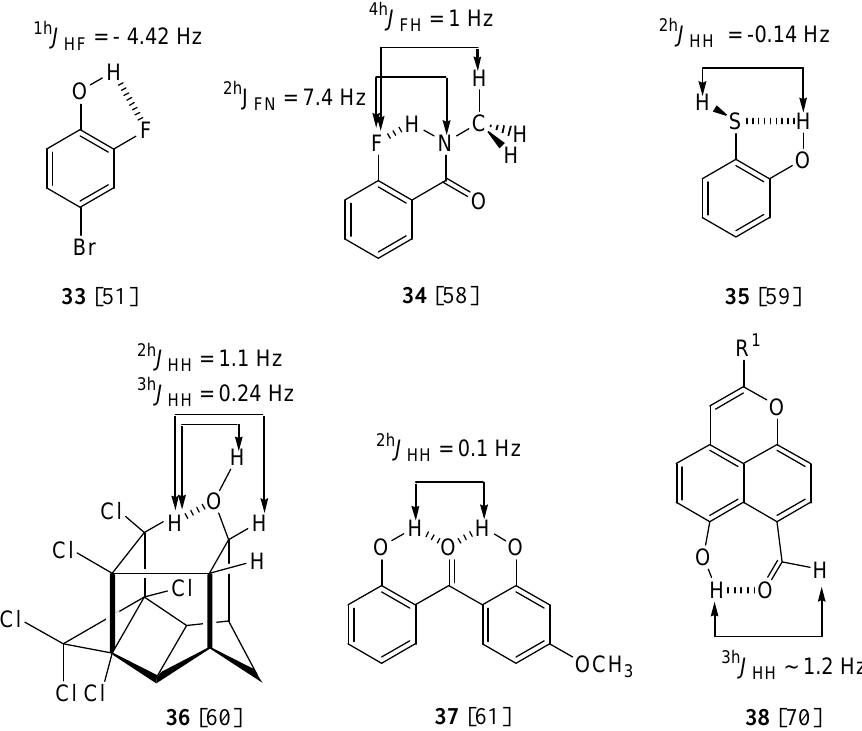
Scheme 2 . Some examples of scalar couplings through intramolecular HBs